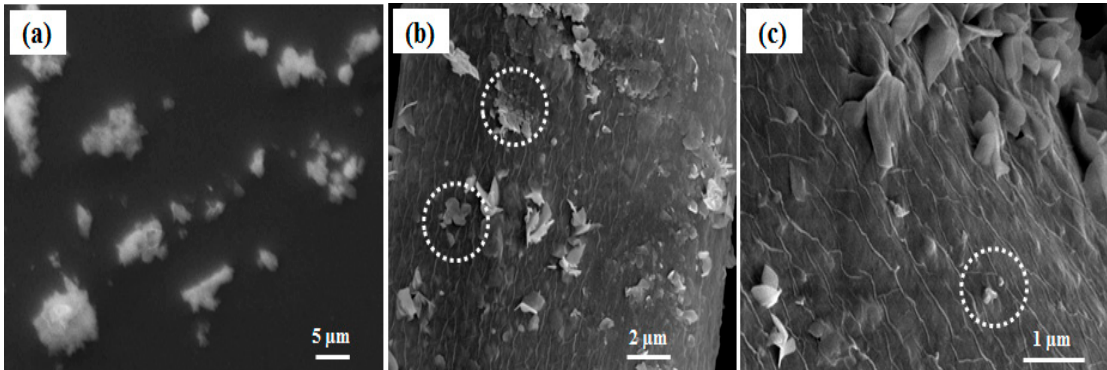
Figure 2. SEM image of ( a ) ZnO particles devoid of silk fibers; ( b ) and ( c ) shows ZnO nanoflakes on silk fiber (ZnSk) structures and the aggregations of small particles; dotted circular regions in white display aggregations of pseudo smaller spherical particles.